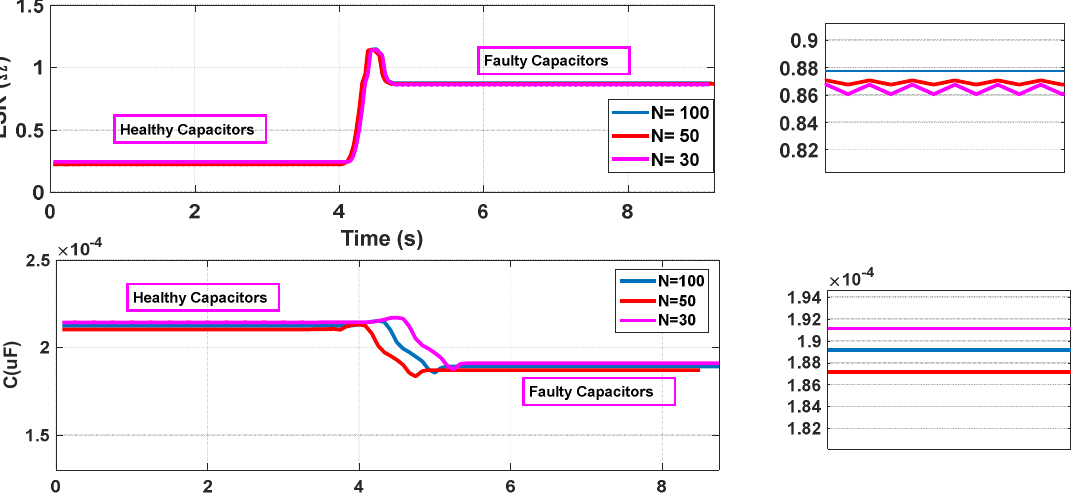
Figure 13. Estimated ESR and C in both states (healthy and faulty) as a function of the number of data samples N.